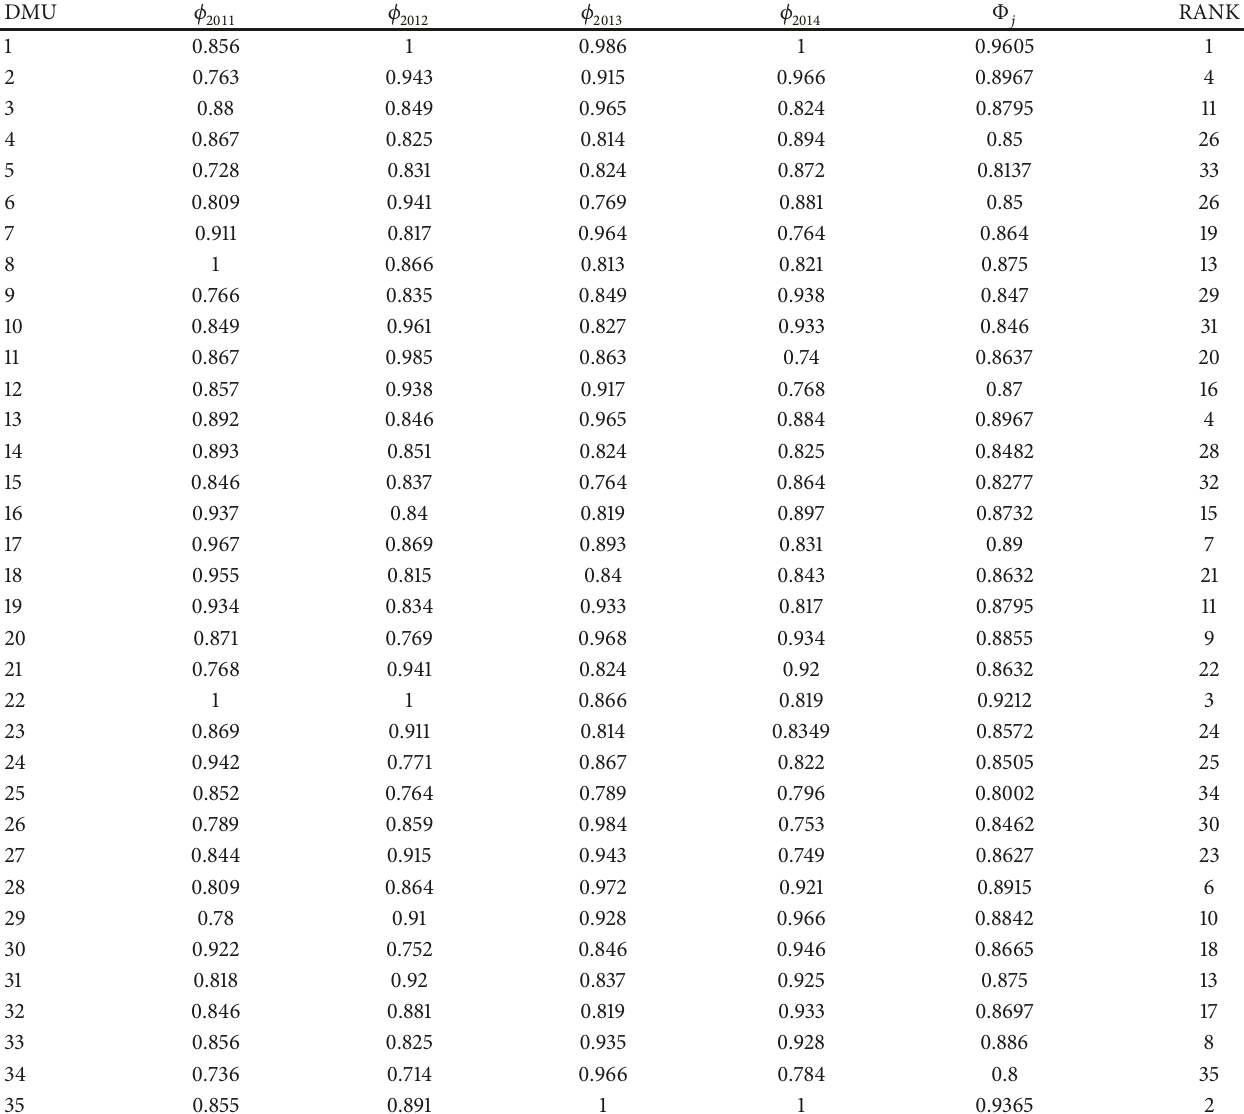
Table 6: Efficiency values for 35 suppliers in 4 periods (Input-oriented dynamic DEA model).